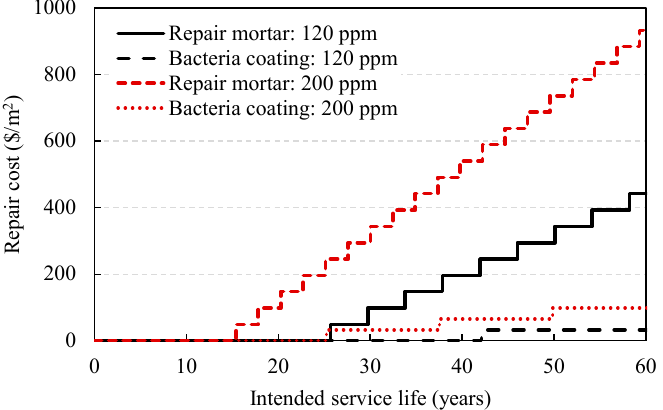
Figure 16. Variation in repair cost due to increase in service life with normal repair mortar and bacteria-coating material.